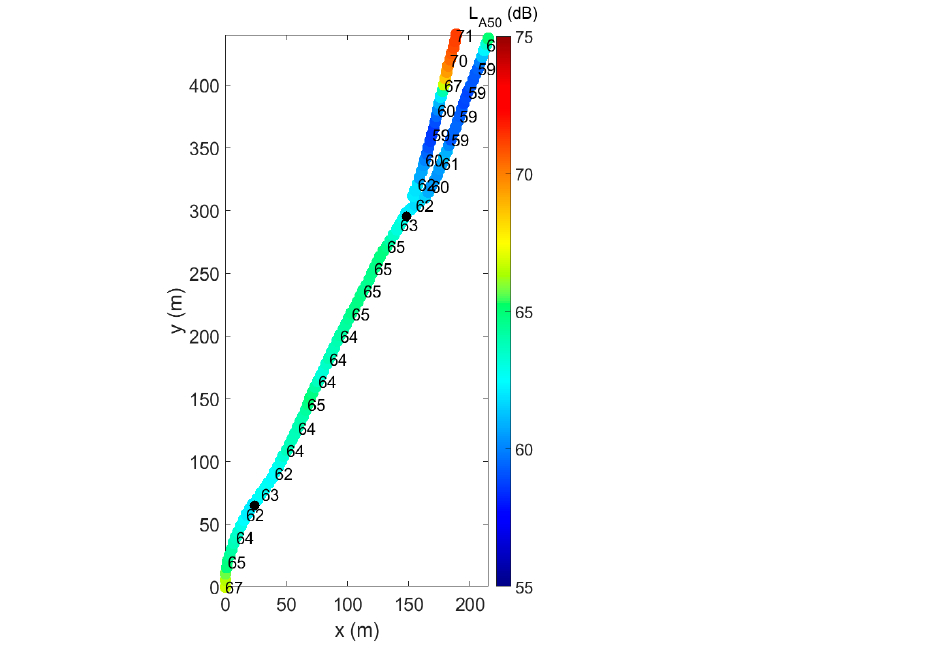
Figure 2. Spatial distribution of the sound pressure levels measured along the cycling path, using the L A,50 indicator during daytime hours in the week when the questionnaires were held. Distances are referenced to the bottom left position (x,y) = (0,0). The survey points are marked by the two black dots.